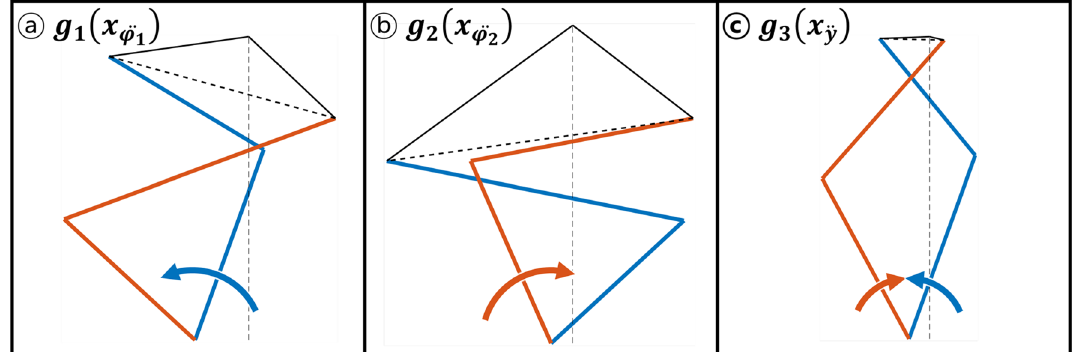
Figure 8. The visualization of the three optimized sets for the dominant degree of freedom. The design variables are mostly at the boundaries due to the limitations of the motor design.